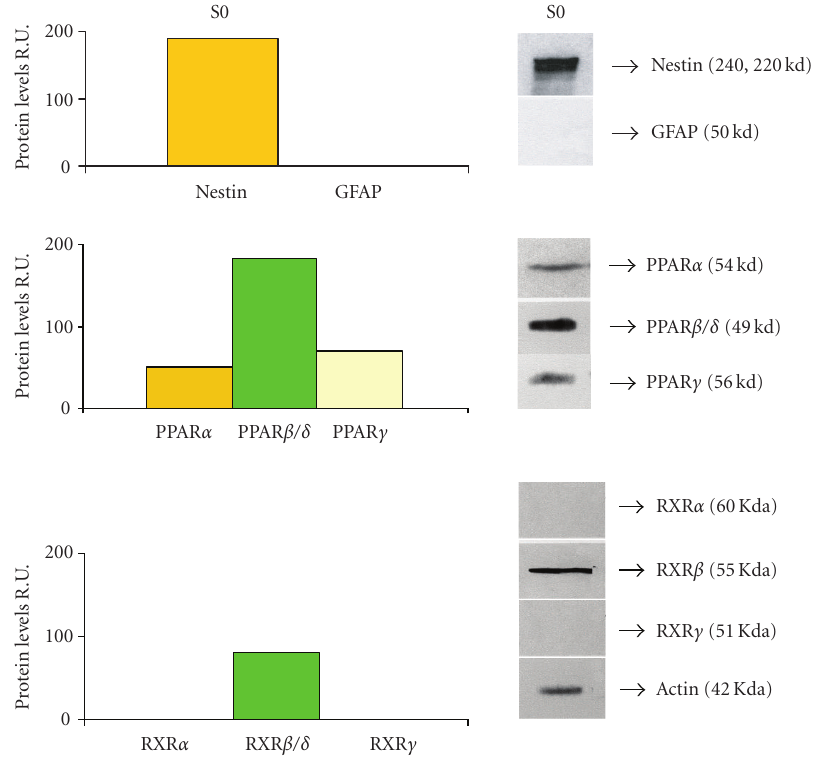
Figure 4: Western blotting and relative densitometric analysis in S0 neurosphere cell lysates. An example of western blotting is shown. Densitometric data are means ± SD of 5 di ff erent